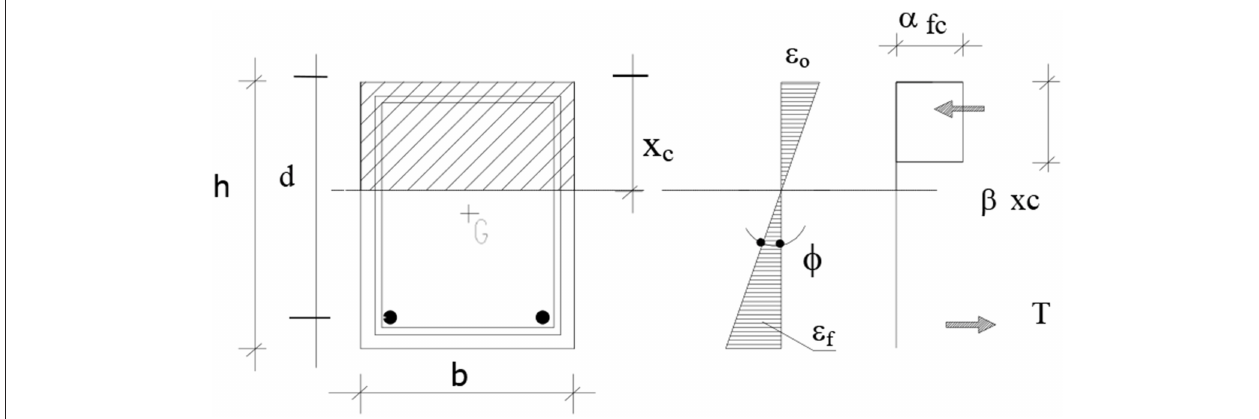
FIGURE 5 | Stress-block approach for the calculation of the flexural strength.